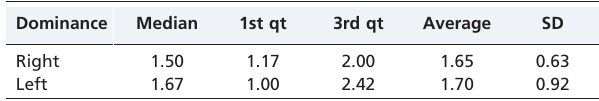
Table 4 – Differences between the right and left radii according to hand dominance.